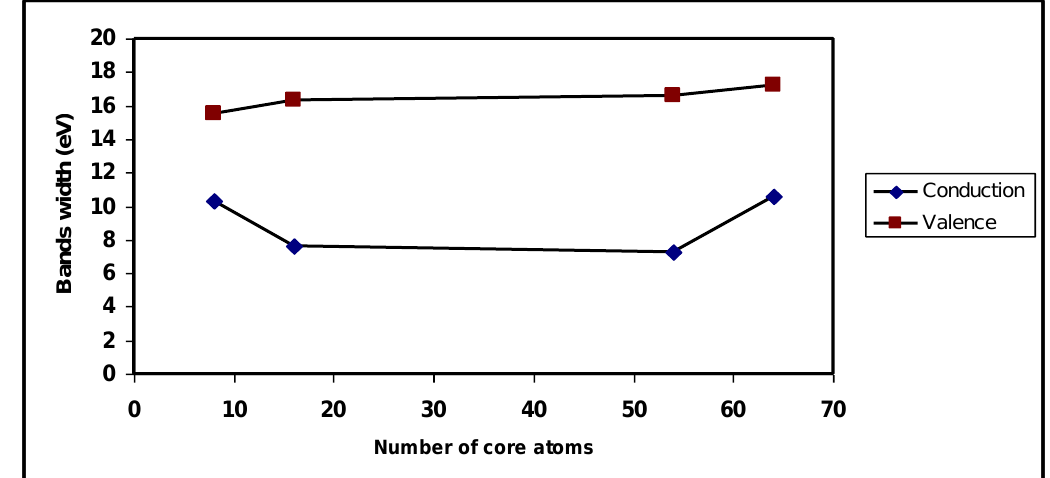
Fig. 7: Valence and conduction bands variation with the number of core LUC atoms of InP nanocrystals.